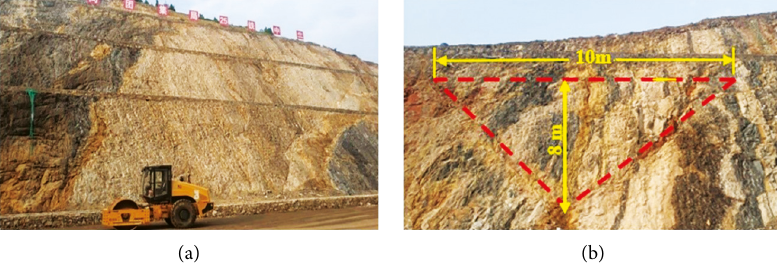
Figure 14: Site diagrams before and after construction. (a) Schematic diagram. (b) Wedge unstable block.